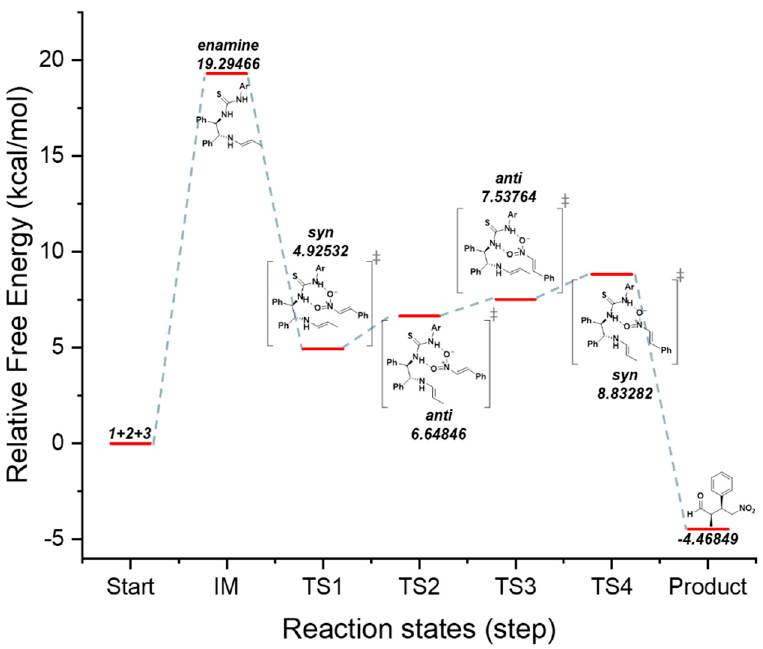
Figure 4. Proposed catalytic mechanism based on B3LYP/6-31G(d,p) calculations and the free en- ergy diagram of the ( R , R )-1,2-diphenylethylenediamine(DPEN)-thiourea-catalyzed enantioselec- tive Michael reaction.